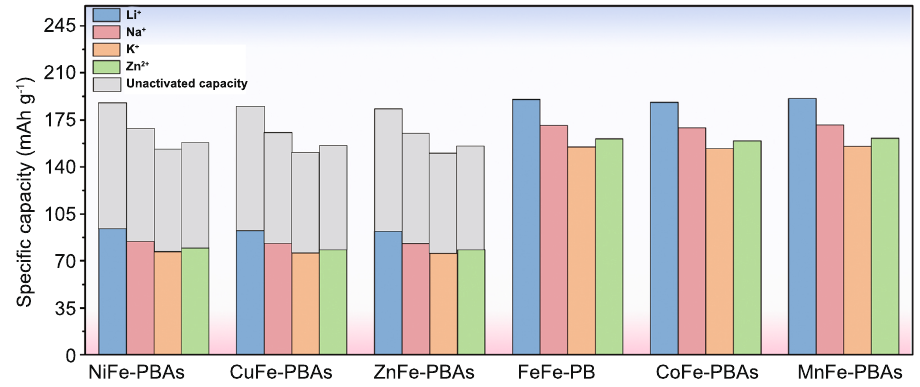
Fig. 4 Theoretical capacity of different PBAs in various aqueous batteries (the shaded part represents the un-activated capacity of the single- atom redox PBAs)